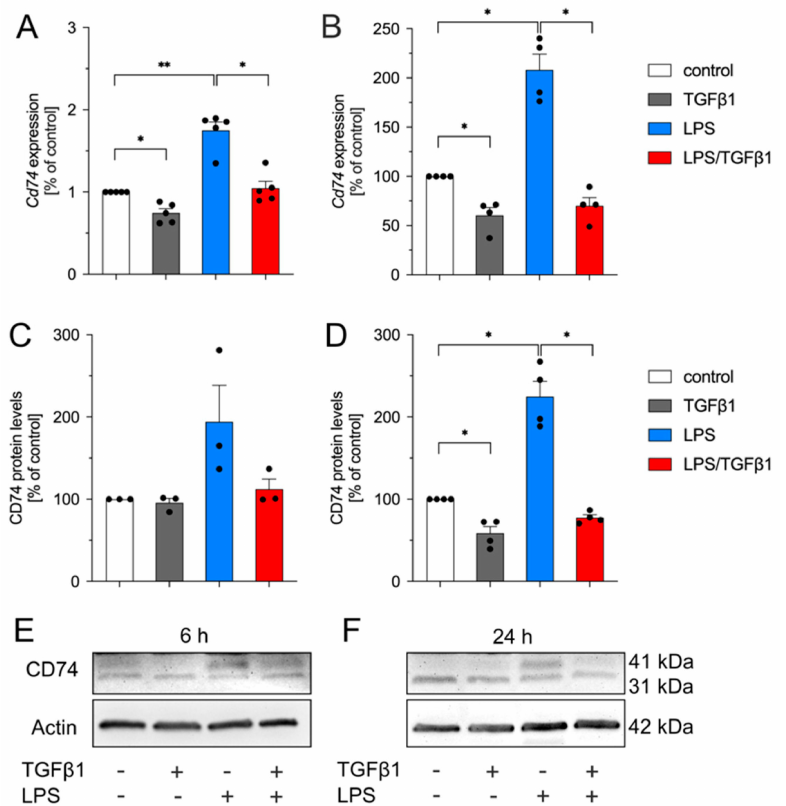
Figure 2. TGF β 1 inhibits LPS-induced expression of Cd74 in primary microglia. Expression of Cd74 after treatment of primary microglia with TGF β 1 (5 ng/mL), LPS (1 µ g/mL), or a combination of both factors for 6 h ( A ) and 24 h ( B ). Quantifications of CD74 total protein levels after treatments for 6 h ( C ) and 24 h ( D ). ( E , F ) Representative western blot images for the analyzed experimental time points. Data are given as means ± SEM for at least three independent experiments. p -values derived from one-way ANOVA followed by Tukey’s multiple comparison tests are shown as follows: * p < 0.05 and ** p <